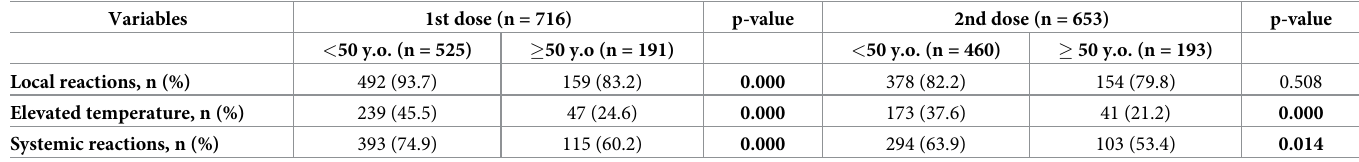
Table 4. Adverse events following vaccination depending on the age after 1st and 2nd dose, respectively.